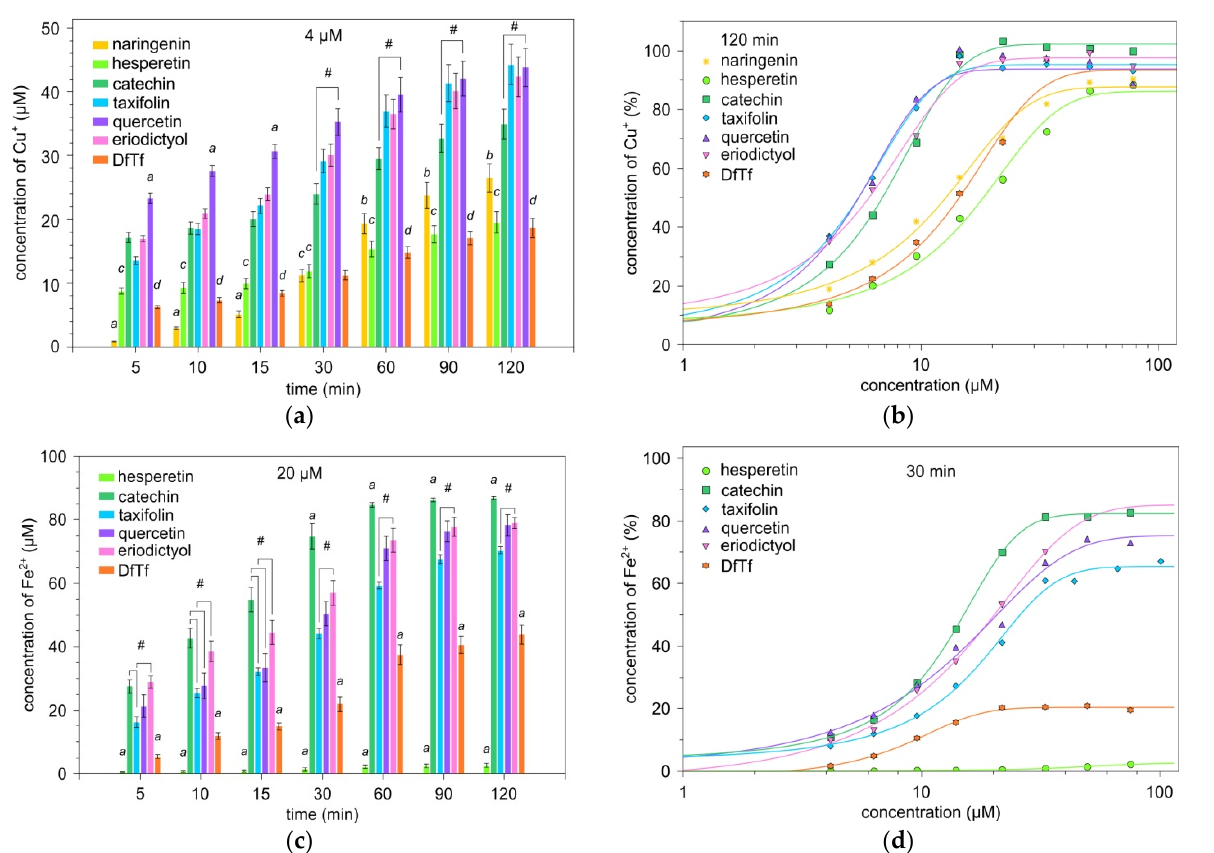
Figure 3. Metal-reducing activity of polyphenols. Reduction of cupric ( a , b ) and ferric ( c , d ) ions depending on the time ( a , c ) and concentration of polyphenols ( b , d ). a differences are significant compared with other compounds; b differences are significant compared with catechol-containing compounds; c differences are significant compared with catechol-containing compounds, with the exception of DfTf; d differences are significant compared with other compounds, except hesperetin; # significant differences between the compounds, p < 0.05.